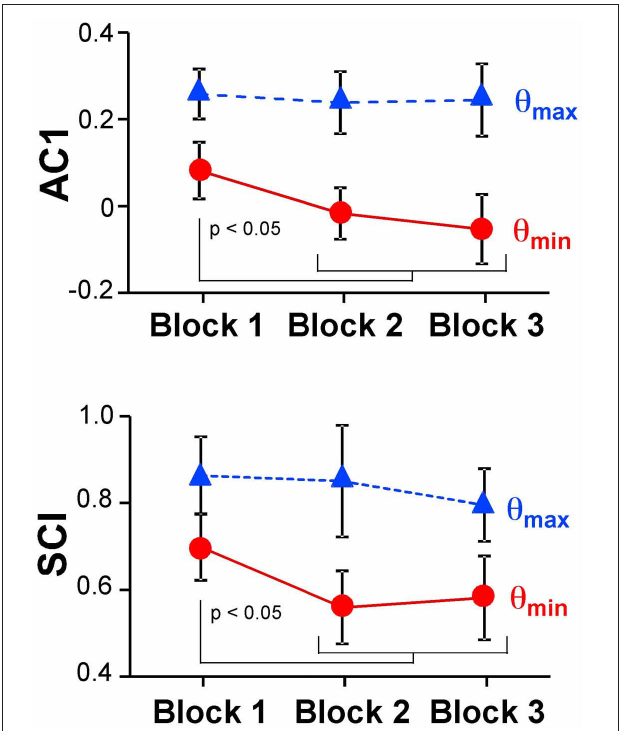
FIGURE 6 | Average results of the autocorrelation AC1 and scaling index SCI at maxima and minima directions across the three blocks.